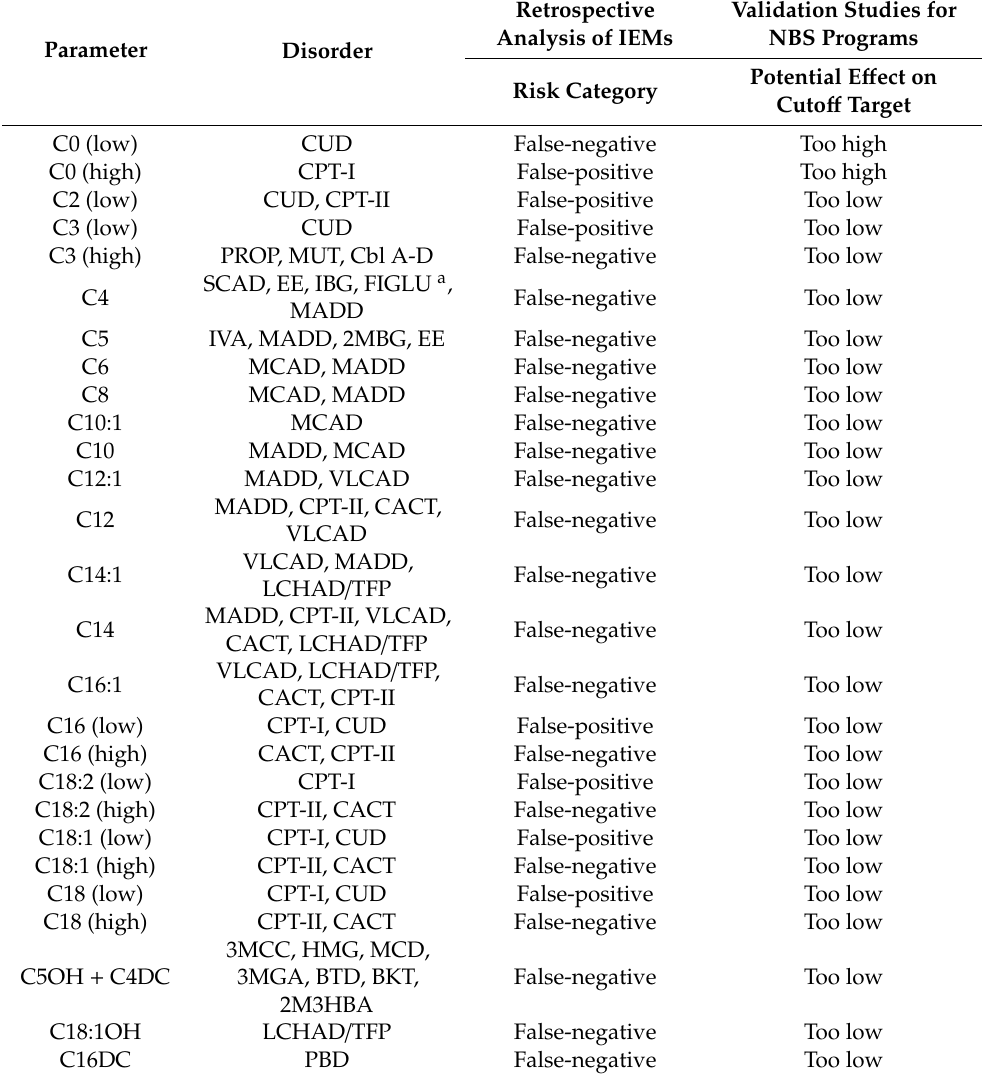
Table 1. Potential impact of metabolite instability on the interpretation of carnitine and acylcarnitine